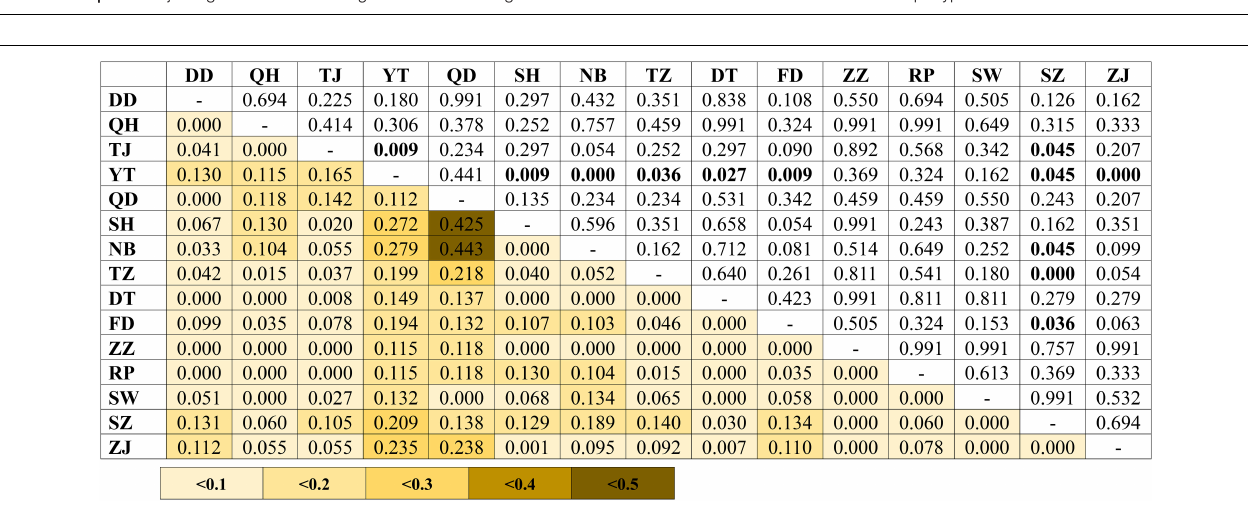
FIGURE 4 | Median-joining network of Tridentiger bifasciatus along the coast of the China Seas based on the nuDNA haplotypes.